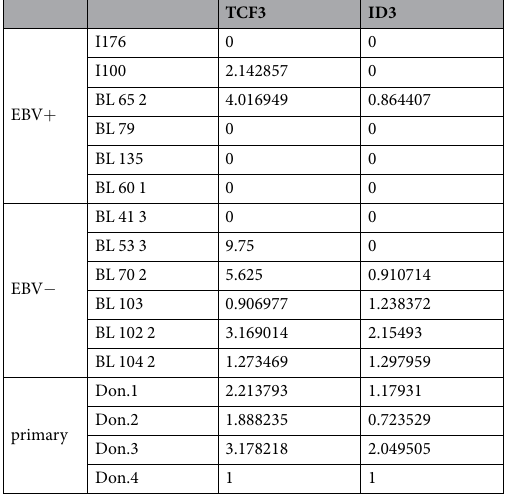
Table 3. mRNA levels of ID3 and TCF3 in EBV ( + ) and ( − ) BL cells and primary B